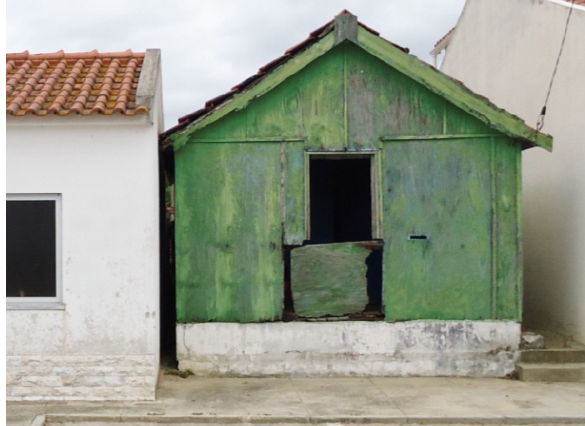
Figure 8: ICT platform application for evaluation of status of wooden stilt-houses conservation in Escaroupim: the wooden stilt-house identified by no. 10, is the most problematic